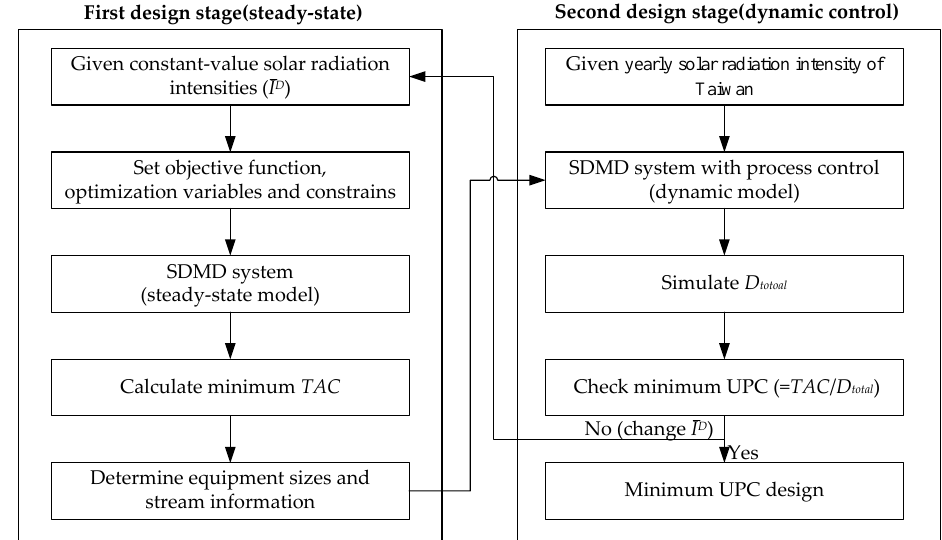
Figure 4. Flow chart of the two-stage optimization.